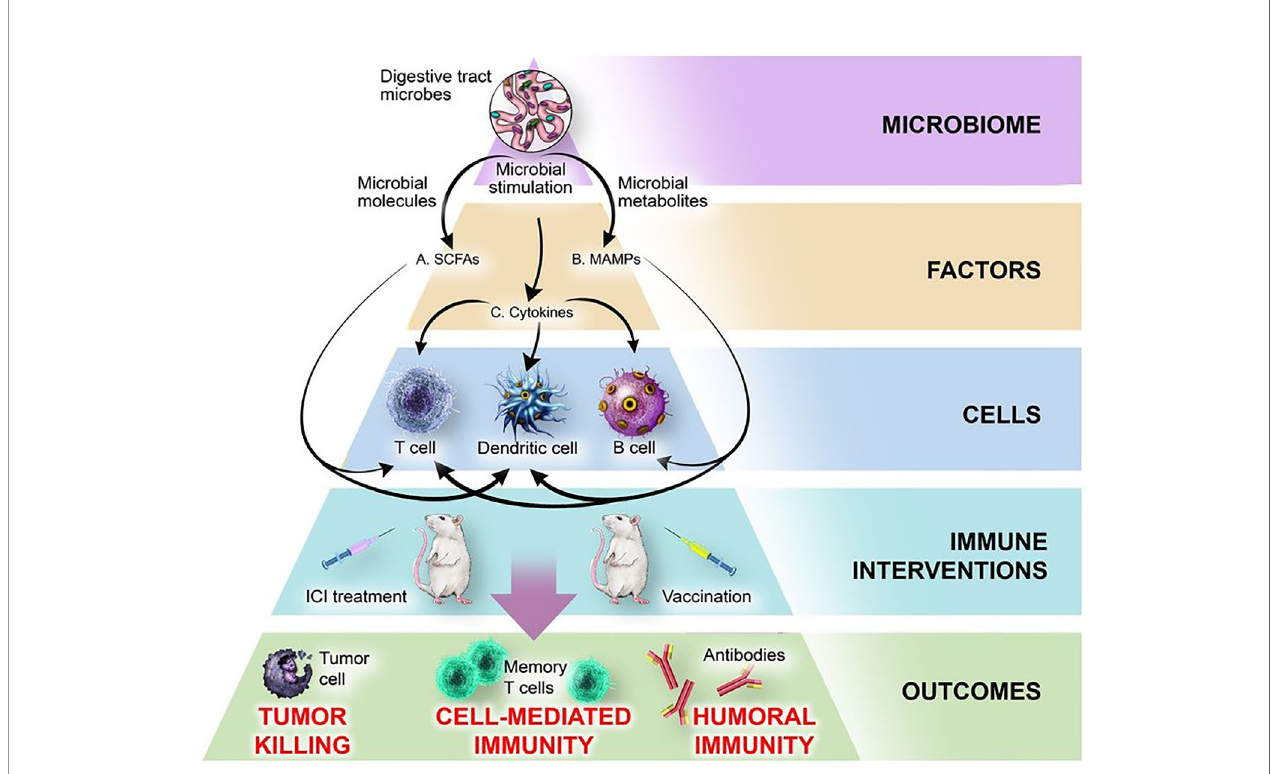
FIGURE 2 | Mechanisms by which the microbiome in fl uences response to ICI treatment and vaccination. The microbiome produces microbial factors and in fl uences host factors and cells, thereby in fl uencing the outcomes of immune interventions. (A) Microbiome-derived short-chain fatty acids (SCFAs) bind receptors including GPR43 on DCs and T cells, leading to changes in cytokine production, antigen presentation, cellular polarization, and interactions with other cell types. (B) Microbe- associated molecular patterns (MAMPs) including fl agellin, polysaccharide A, fucosylated antigens, unmethylated CpG DNA, and peptidoglycan bind pattern recognition receptors on DCs (NOD2, TLR2, TLR3, TLR9, DC-SIGN) or B cells (TLR5) and modulate activation, cytokine production, and immune cell function. (C) Microbiome-dependent changes in production of cytokines (IL-1 b , IL-12, IL-18, IFN- g , IL-10) produced by intestinal DCs or epithelial cells broadly affect immune cell